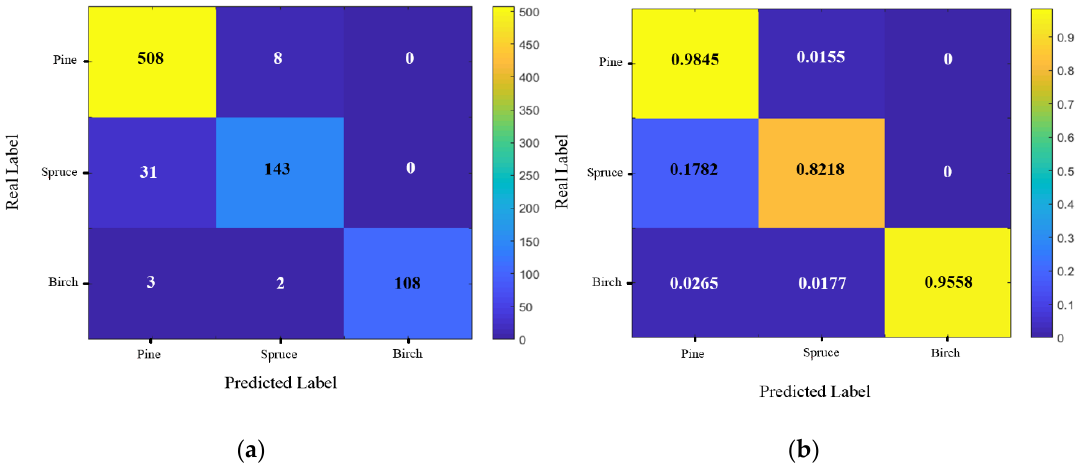
Figure 8. Confusion matrices of the multi-layer perceptron (MLP) with all 37 input layers (HS + RGB + CHM); ( a ) case numbers, ( b ) normalized percentages.